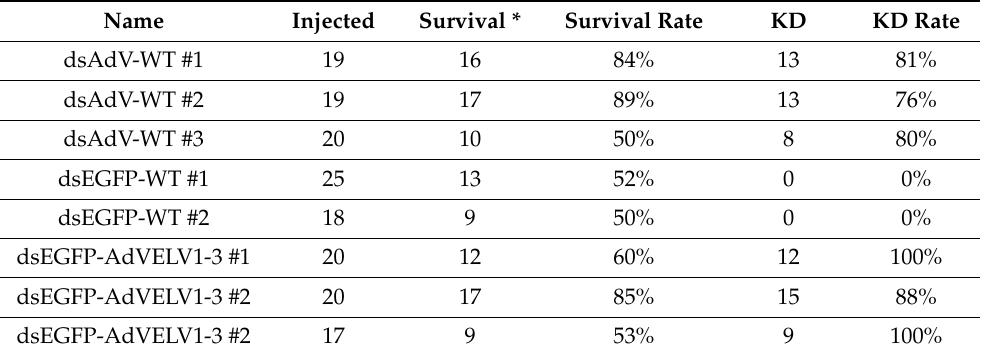
Table 5. RNAi results in A. domesticus .